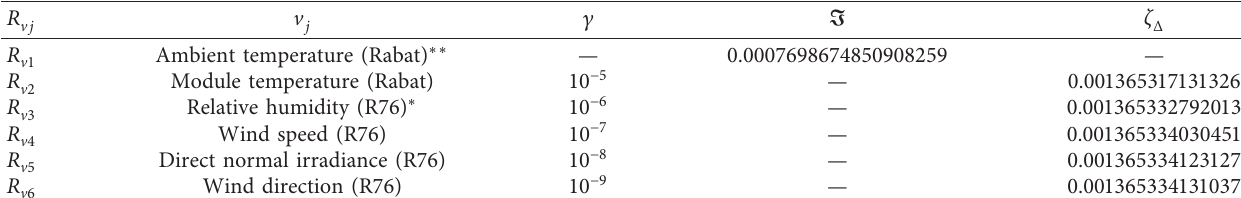
for 60kWp PV power station. Δ